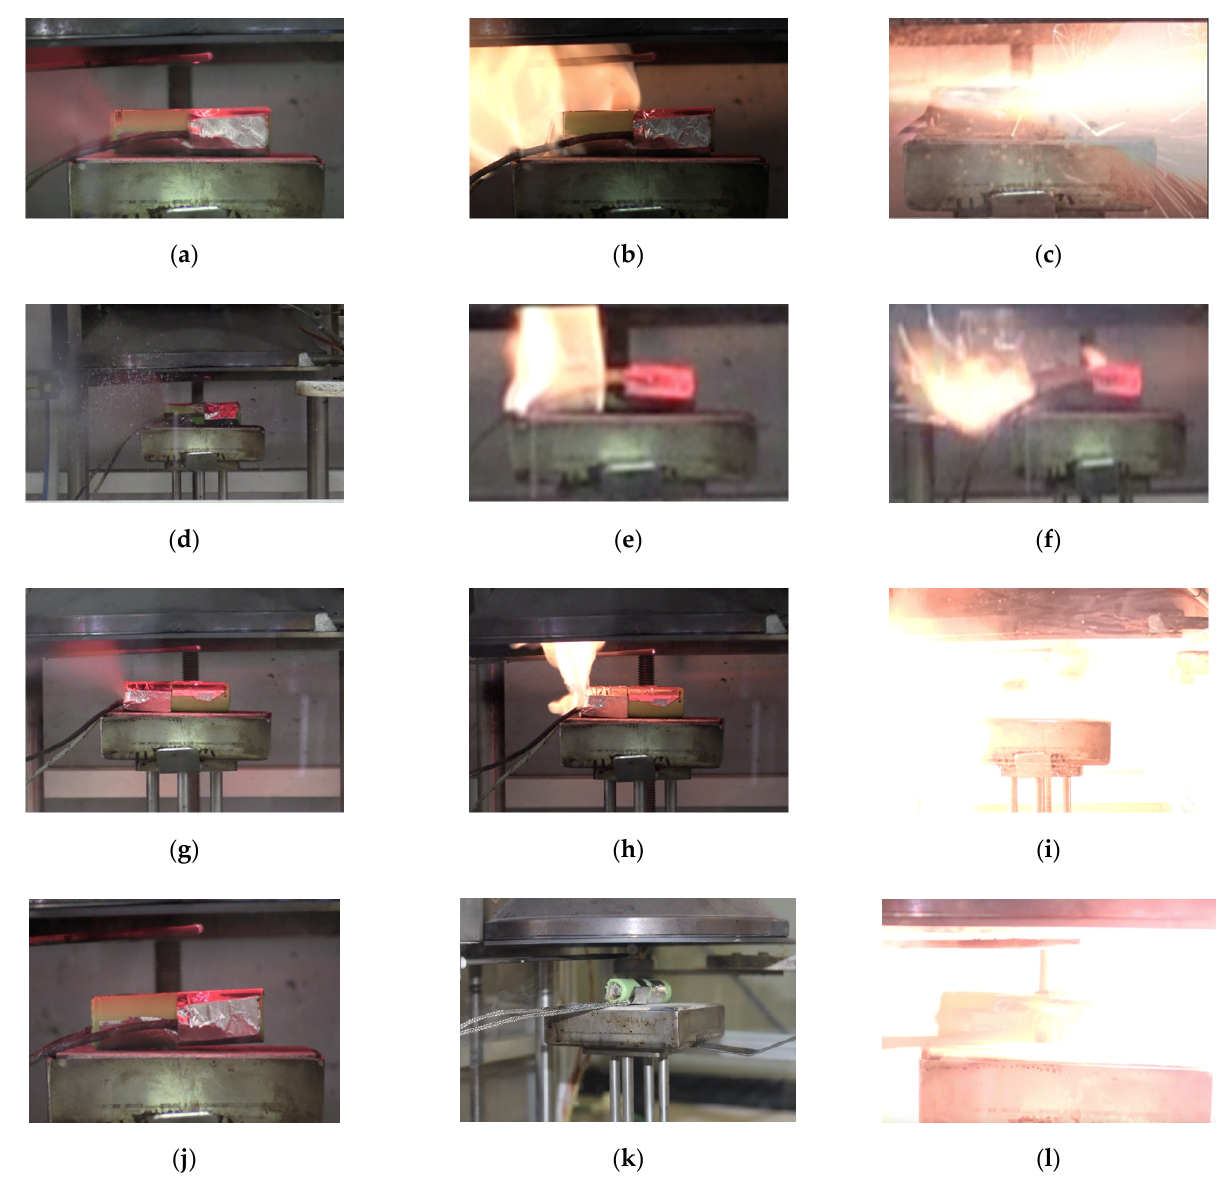
Figure 3. The main phases of a cell test at cone calorimeter: ( a – c ) SoC = 0% at 50 kWm − 2 : ( a ) venting at 138 s; ( b ) fire at 140 s; ( c ) catastrophic failure of the cell at 196 s. (d–f) SoC = 50% at 50 kWm − 2 : ( d ) venting at 204 s; ( e ) fire at 206 s; ( f ) catastrophic failure of the cell at 250 s. ( g – i ) SoC = 100% at 50 kWm − 2 : ( g ) venting at 171 s; ( h ) fire at 173s ; ( i ) catastrophic failure of the cell at 226s. ( j – l ) SoC = 100% at 15 kWm − 2 : ( j ) 0 s; ( k ) venting at 514 s; ( l ) catastrophic failure of the cell at 817 s.